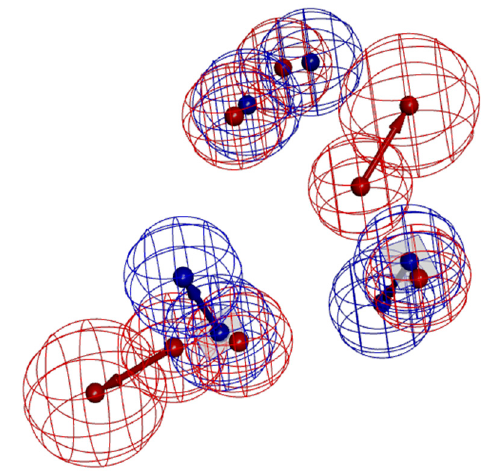
Figure 5. Comparison of model A02 (red) and B10 (blue) pharmacophores. Table 2. Feature set, selectivity score, and validation results of the ligand-based pharmacophore models.